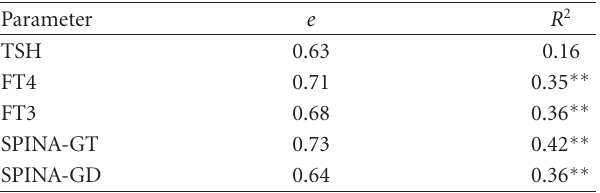
Table 3: Test-retest reliability measures of TSH, FT4, FT3, SPINA-GT, and SPINA-GD from repeated measurements with at least one month interval in 20 healthy volunteers from the SPINA network [11, 116]. e : repeatability = (interindividual vari- ance)/(intraindividual variance + interindividual variance) [300]. Larger figures denote higher